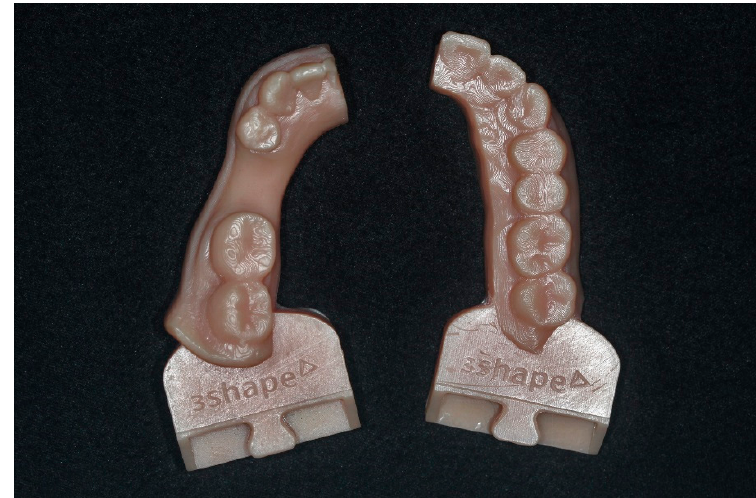
Figure 2. Mandibular ( left ) and maxillary ( right ) resin model. Two different ISB systems were evaluated ( n = 12): the PEEK short scan body (SSB) group (length: 7 mm) (Link type M scan body; MYFIT, Daegu, South Korea) and the PEEK long scan body (LSB) group (length: 15 mm) (Osstem Regular TS scan body; Osstem, Seoul, South Korea) (Figure 3A,B). Two different conventional impression techniques were also evaluated ( n = 12): the PEEK short scan body with coping plastic cap (CPC) group (Link type M scan body) and the pick-up coping (PUC) group (hex type; Osstem, Seoul, South Korea) (Figure 3C,D).